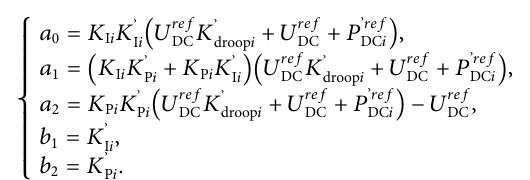
Frontiers in Energy Research |